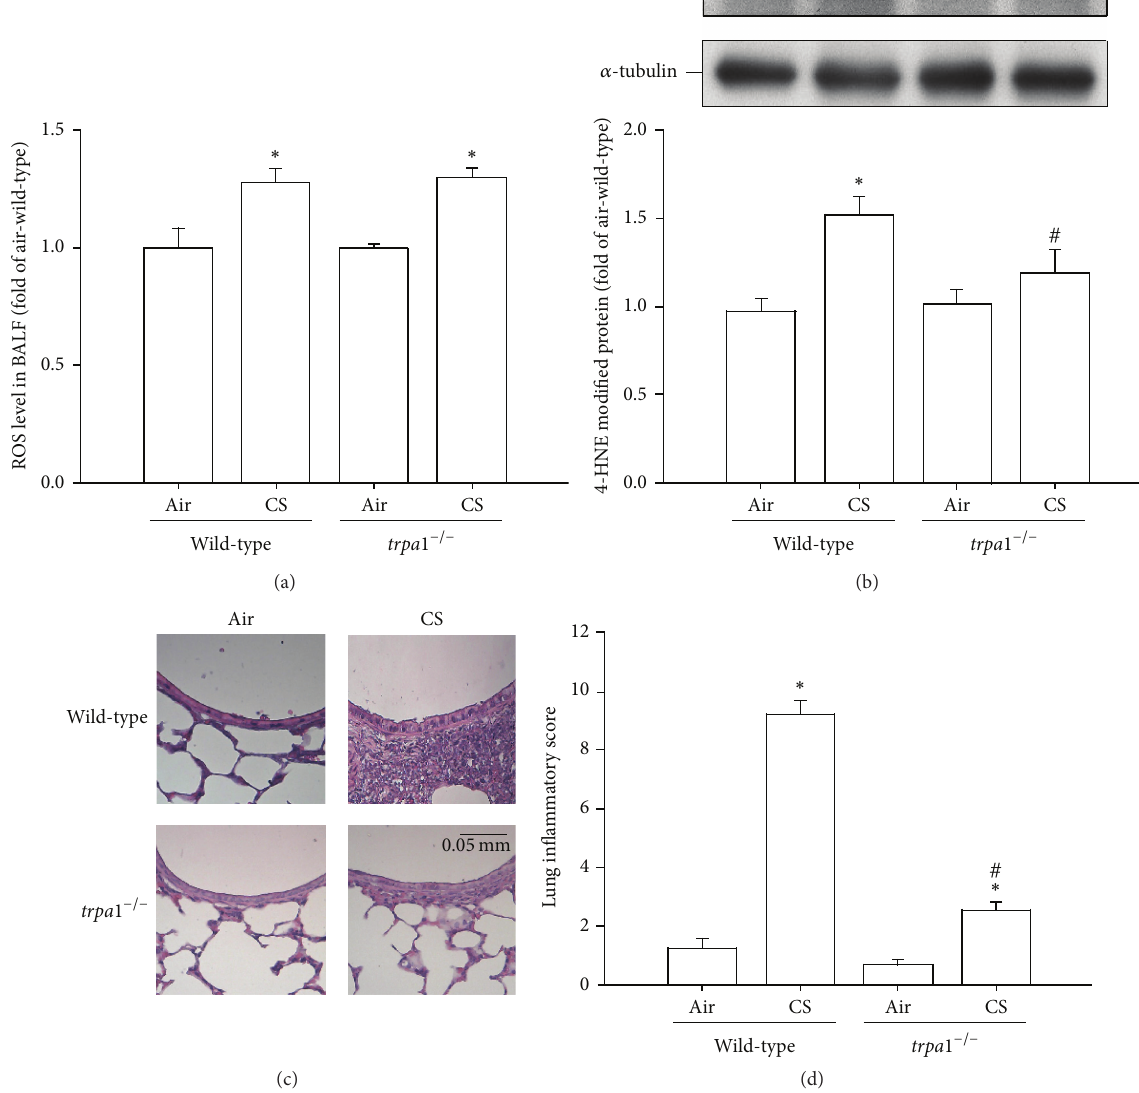
Figure 7: Comparisons of cigarette smoke- (CS-) induced oxidative stress and lung inflammatory score in wild-type and trpa1 −/− mice. Mice werechronicallyexposedtoairorCSfor4weeks.(a)LevelsofROSinthebronchoalveolarlavagefluid(BALF)weresampledimmediatelyafter the last air or CS exposure across the four study groups. Levels of ROS were measured by DCFH-DA fluorescent probe assay. (b) Expression of 4-HNE modified protein, a biomarker of oxidative stress, in lung tissues was analyzed by Western blotting. (c) Representative images of H&E stained lung sections obtained from air-exposure or CS-exposure wild-type and trpa1 −/− mice. (d) Lung inflammatory scores were calculated according to the sum of the levels of cell infiltration and damage levels assessed from the lung sections. Data in each group are mean ± SEM from nine mice. ∗ 𝑝 < 0.05 versus the air-exposure group in both genotypes; # 𝑝 < 0.05 versus the CS-exposure wild-type